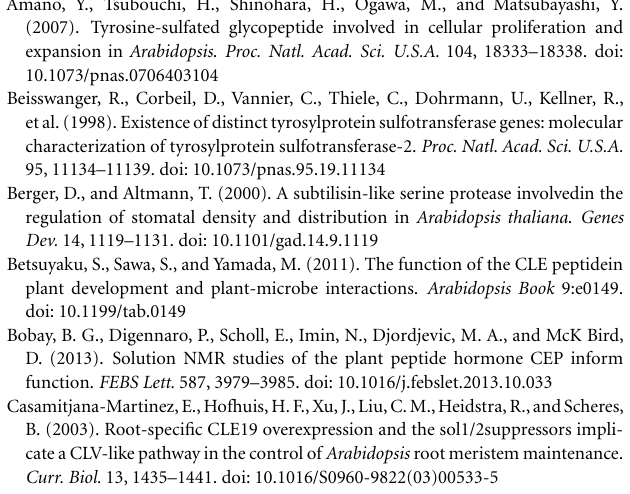
FIGURE 2 | Structures of small secreted peptides. (A) The mature form of the CLAVATA3 peptide. Hydroxylated proline residues are indicated by asterisks. (B) Ribbon models of SCR/SP11 and stomagen presented from two perspectives.The disulfide bonds are depicted as ball-and-stick models with residue name.These models were generated using MOLMOL (Koradi etal.,